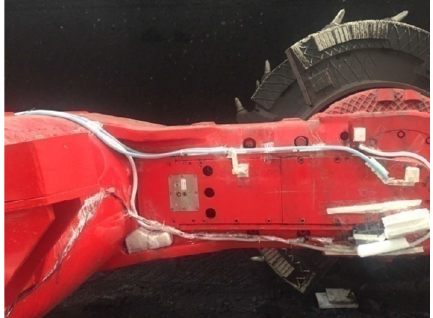
Fig. 4 The locations of sensors Fig. 5 Oblique cutting signal in planetary